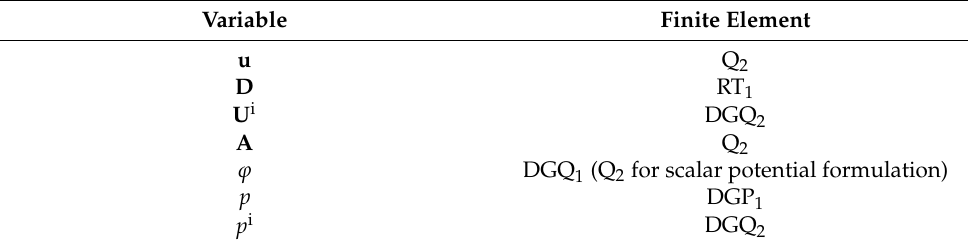
Table 2. Finite elements used for example